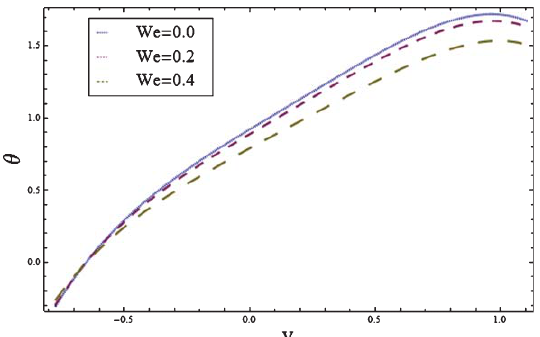
Fig. 9. Plot showing θ versus y . Here a = 0 . 3, b = 0 . 5, d = 1, φ = π/ 4, (cid:14) = 1 . 5, n = 0 . 398, Bi